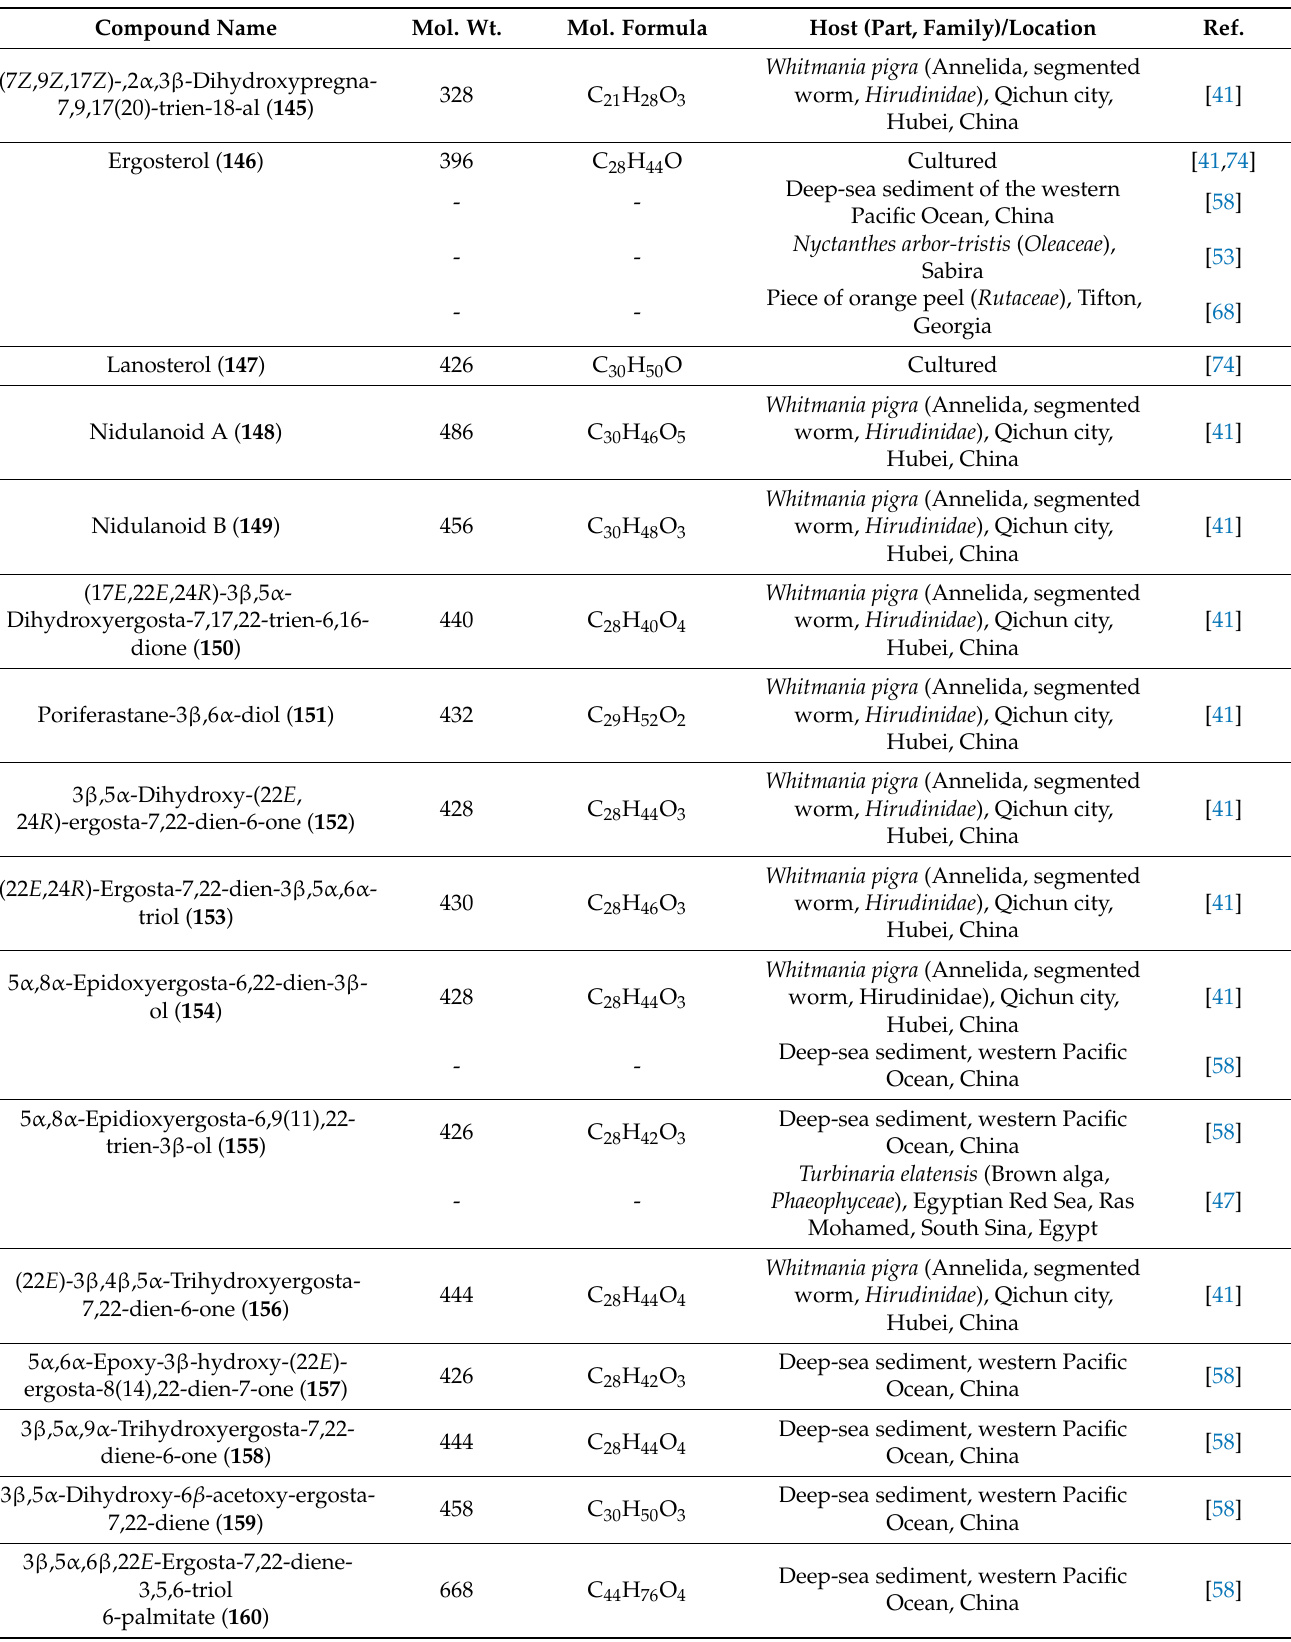
Table 11. Sterols reported from A. nidulans